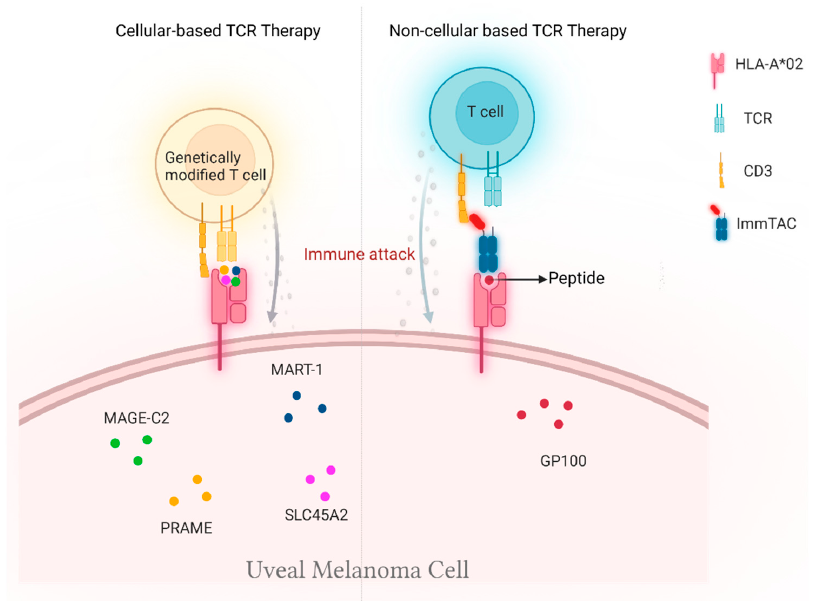
Figure 2. Schematic representation of HLA-A*02-dependent TCR-based cellular therapies in mUM patients.